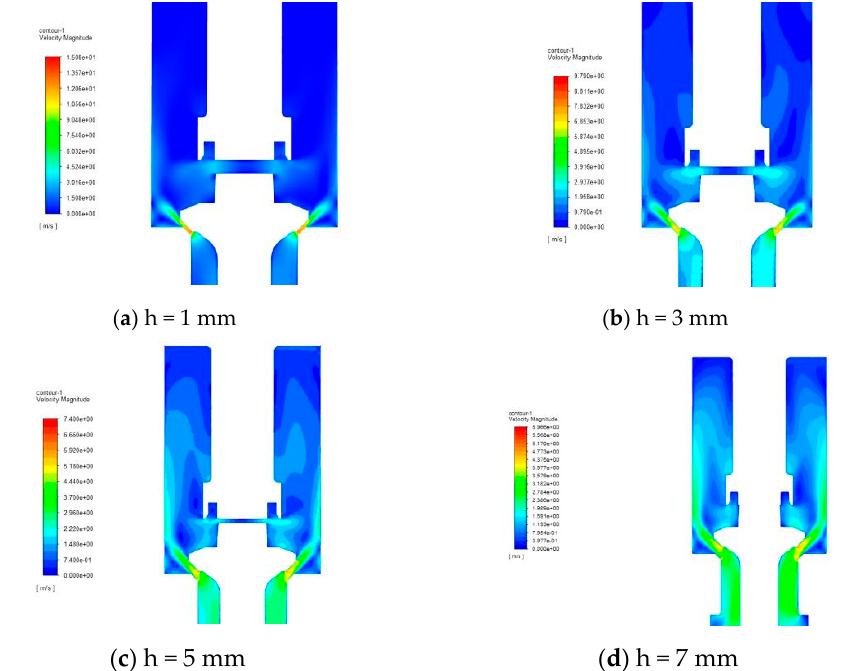
Figure 8. Velocity distributions for the different discharge valve opening lifts.